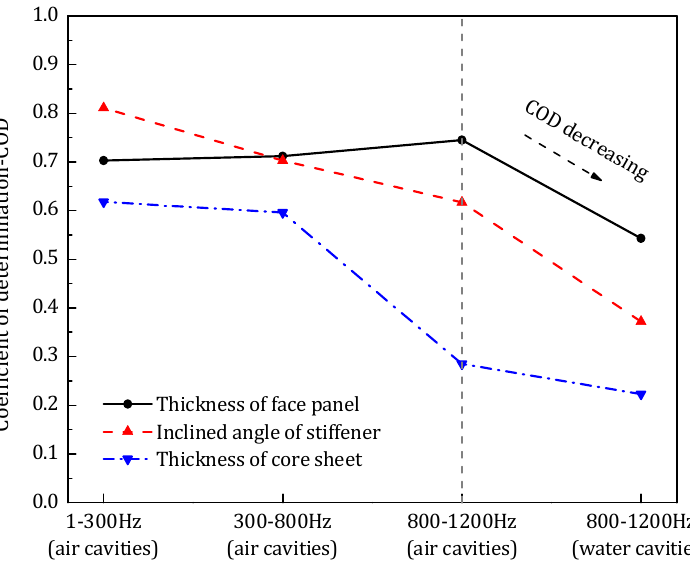
Figure 30. The variation of COD of design parameters with respect to STL avg in different optimization models targeting different frequency ranges.